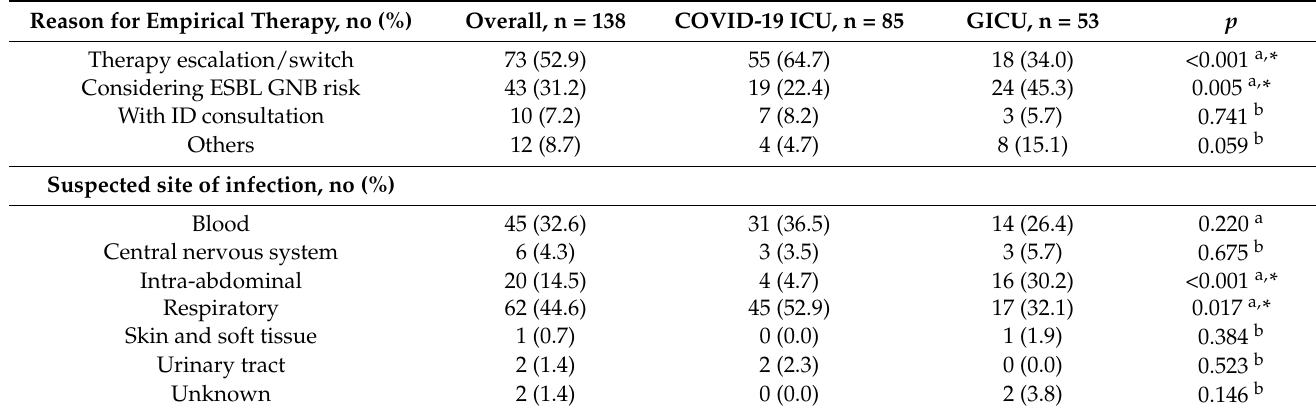
Table 4. Characteristics of empirical carbapenem